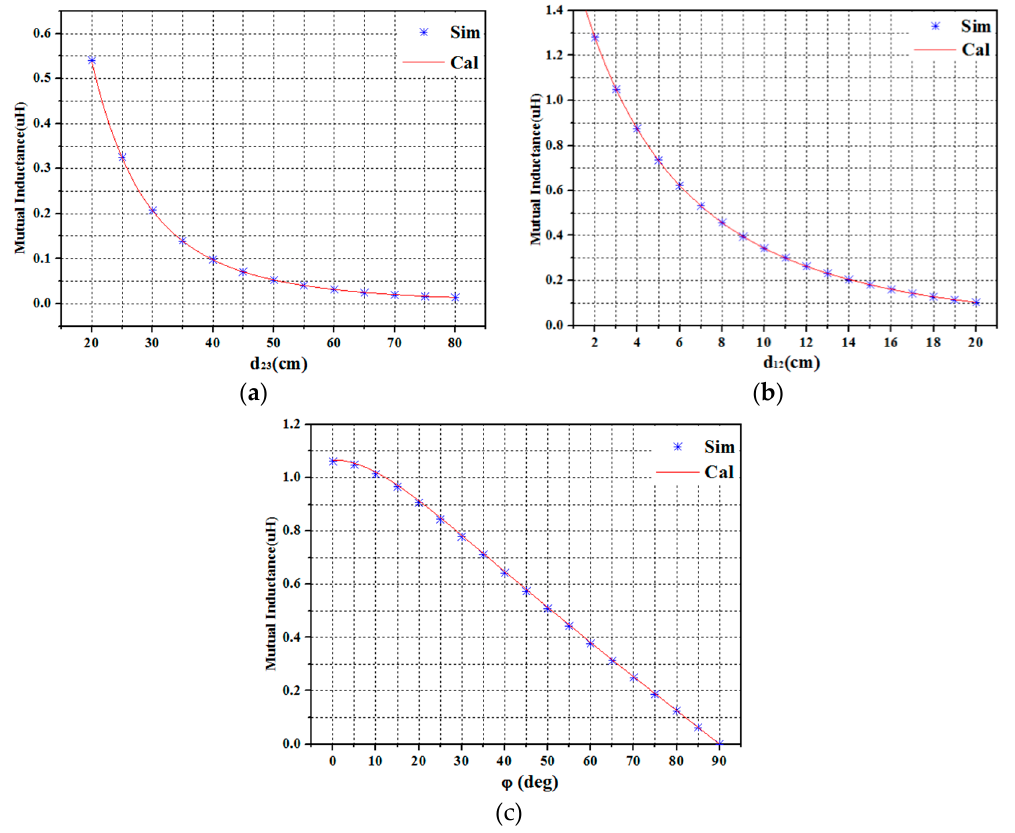
Figure 8. Comparison of the mutual inductance calculations based on this paper and the mutual inductance simulation using Ansys Maxwell 16.0. ( a ) Mutual inductance of Tx coil and Rx coil, ( b ) mutual inductance of Tx coil and drive loop, ( c ) mutual inductance of Rx coil and load loop.